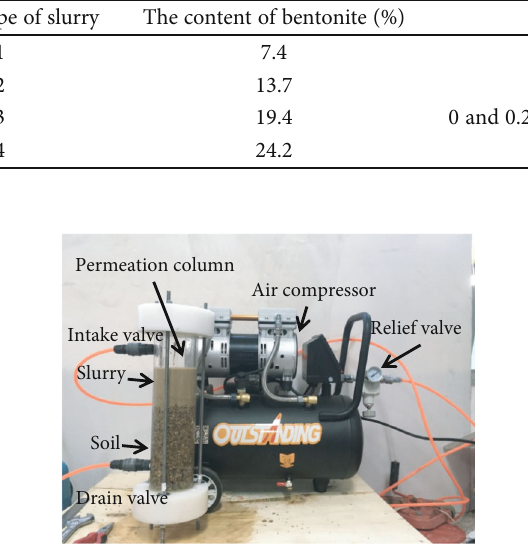
Figure 1: Filter cake airtightness test